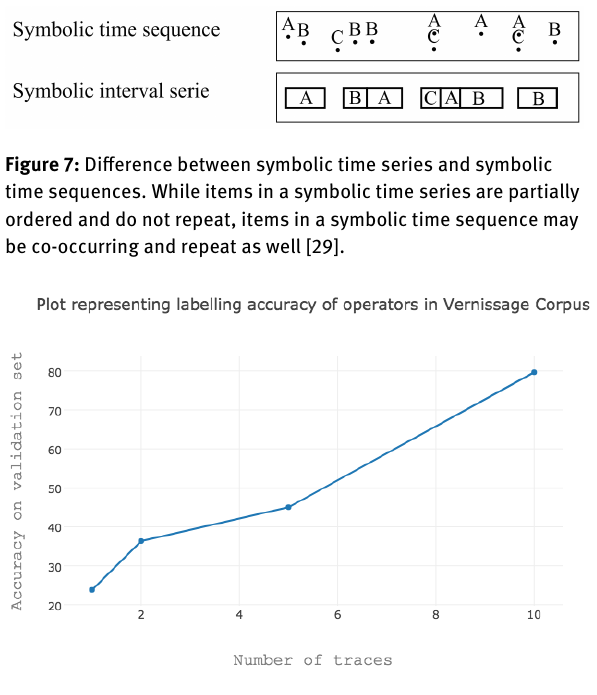
Figure 8: LSTM operator labelling accuracy (128 hidden units, 0.8 dropout